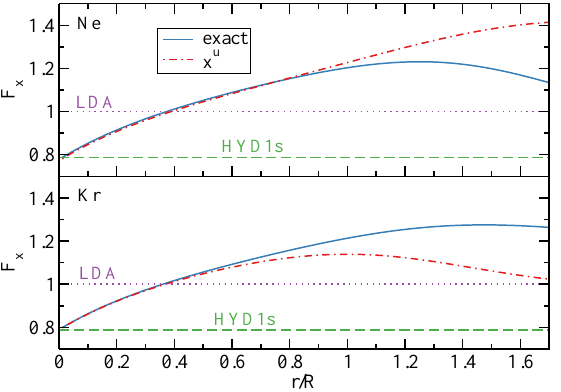
Figure 7. Exchange enhancement factors F x near the nucleus versus scaled radial distance, for the Ne atom (upper panel) and the Kr atom (lower